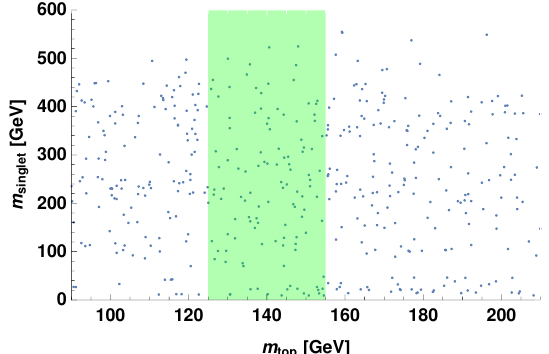
Figure 7 . The mass of the singlet scalar versus the top quark mass for the points M ˜ u < 0 . Points with M ˜ u > 0 generate a vev for the